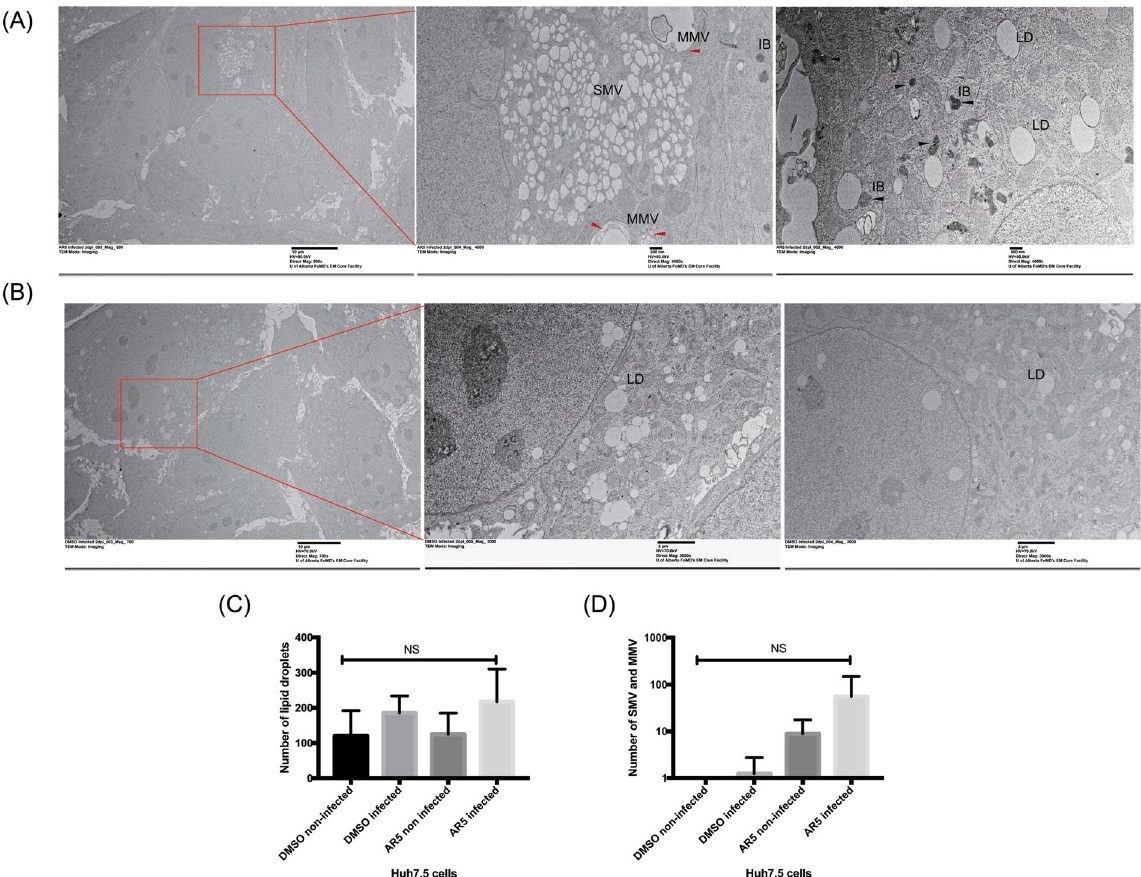
Figure 7. Cells treated with GSK3 β inhibitors accumulate single and multivesicular bodies and tend to have more inclusion bodies. EM analysis of fixed Huh7.5. Cells cultured on thermanox slides. After 4dpi sections were prepared for EM imaging. ( A ) Cells treated with GSK3 β inhibitors show accumulation of single and multivesicular bodies (middle panel, red arrows) which was also apparent by counting the number of SMV and MMV ( D ). Accumulation of inclusion bodies was observed (shown by the black arrows, right panel). This was not obvious in sections taken from control cells treated with DMSO ( A , B ). Lipid droplets were enriched in virus infected cells as shown by the number of lipid droplets counted from 10 fields ( C ). MMV, multiple-membrane vesicles, SMV, single membrane